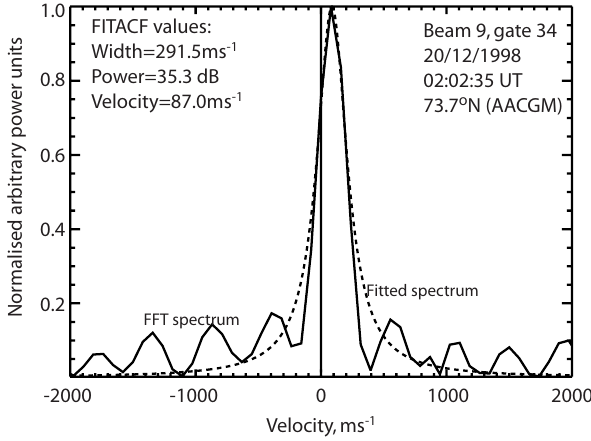
Fig. 5. A typical normalised power spectrum (FFT of the ACF) from the high spectral width region observed by CUTLASS Fin- land on 20 December 1998. This spectrum is from beam 9, gate 34 ( ∼ 73.7 ◦ N AACGM) at 02:02:35UT. A fitted spectrum for the FITACF parameters (assuming an exponential ACF) is overlaid as the dashed